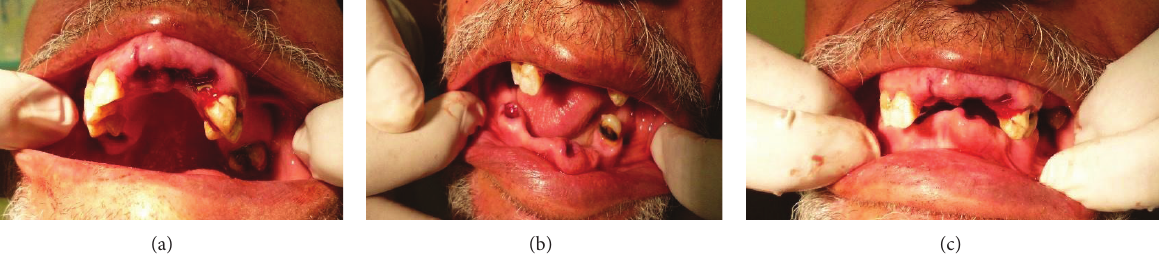
Figure 3: Extraction sites of the remaining roots: (a) maxillary arch, (b) mandibular arch, and (c) both arches together.